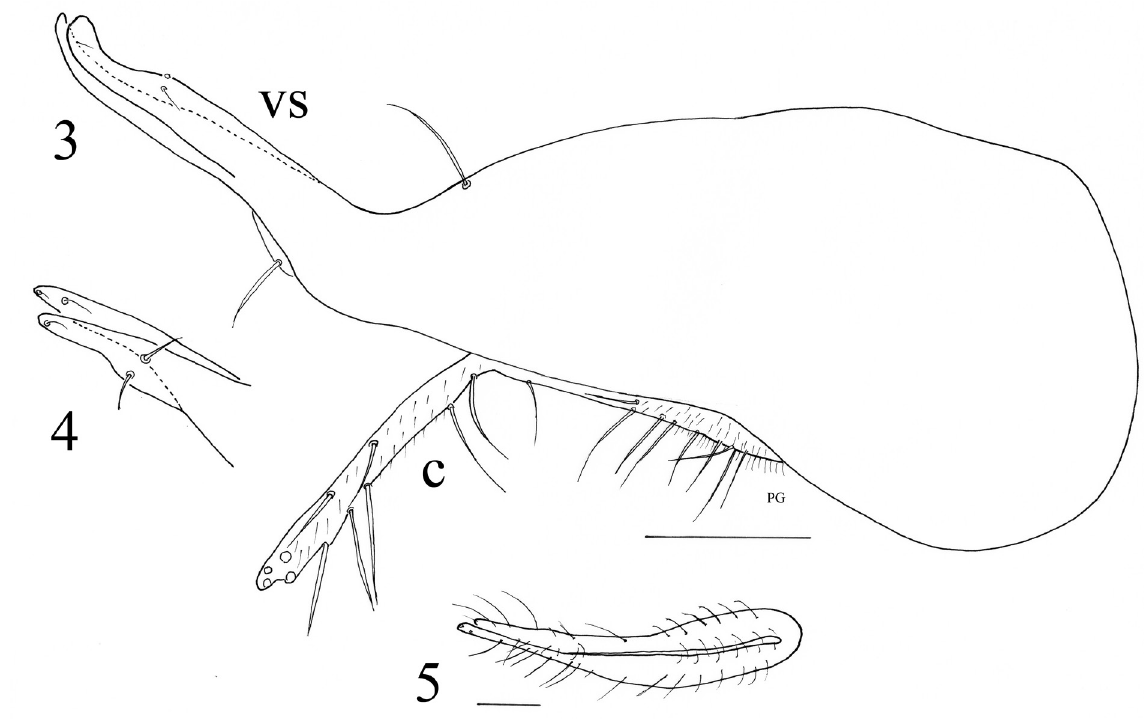
Figs 3–5. Thinophilus boonrotpongi sp. nov., ♂, terminalia. 3 . Genital capsule, lateral view. 4 . Apex of surstylus, dorsal view. 5 . Cerci, dorsal